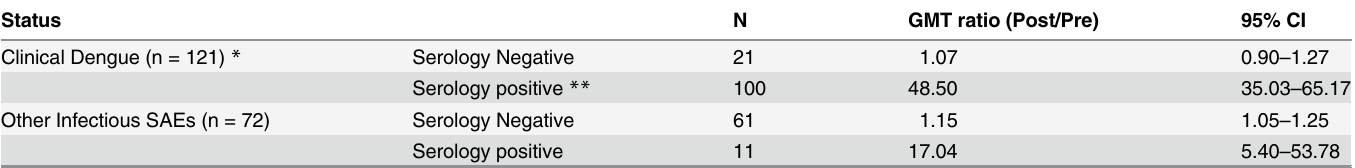
Table 3. Geometric Mean Titer (GMT) ratio (Post/Pre) and 95% confidence interval (CI) for clinical dengue cases (both SAEs and AEs) and subjects with other infectious Serious Adverse Events (SAEs) displayed by serology dengue status.